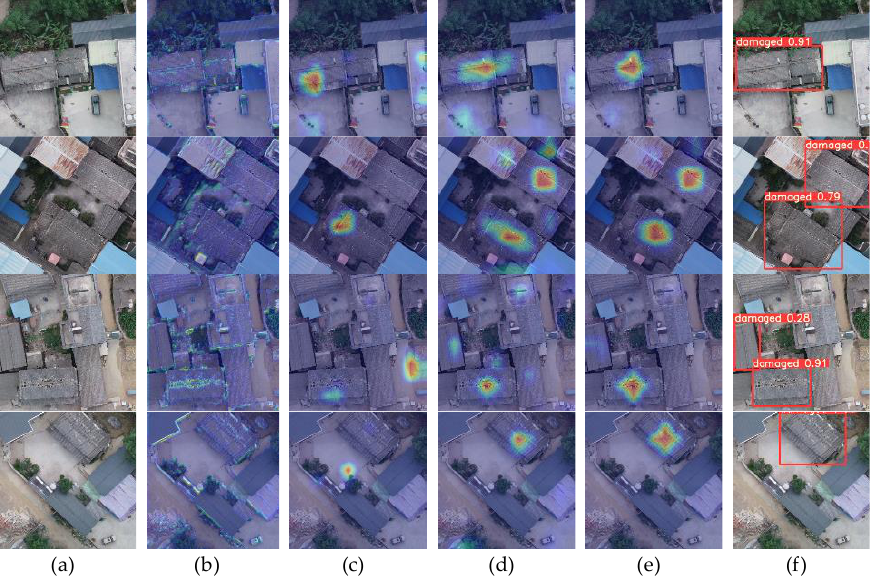
Figure 18. Visualization of the heatmaps. ( a ) The original images; ( b ) The heatmaps of the first layer; ( c ) The heatmaps of the Vision Transformer layer; ( d ) The heatmaps of the BiFPN structure; ( e ) The heatmaps of the output layer; ( f ) The final results.